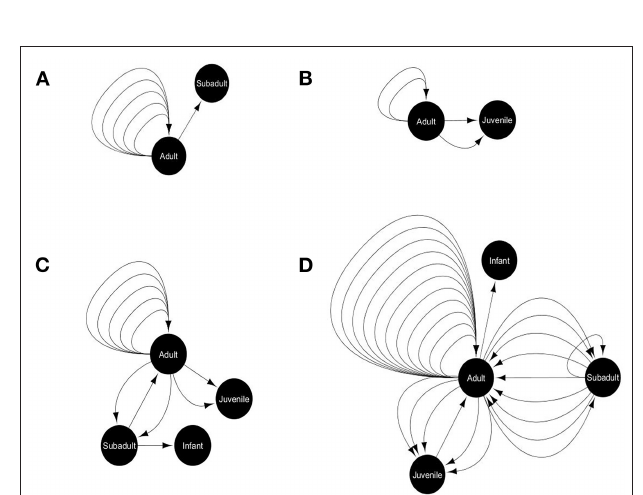
FIGURE 4 | Food-sharing networks of free-ranging hanuman langurs for various food items like (A) bread, (B) brinjal, (C) cauliflower, and (D) peanuts. The solid black circle represents a node, depicting a particular life stage of langurs. The black arrow represents one food-sharing behavior between two nodes, which originated from the initiator and directed toward the